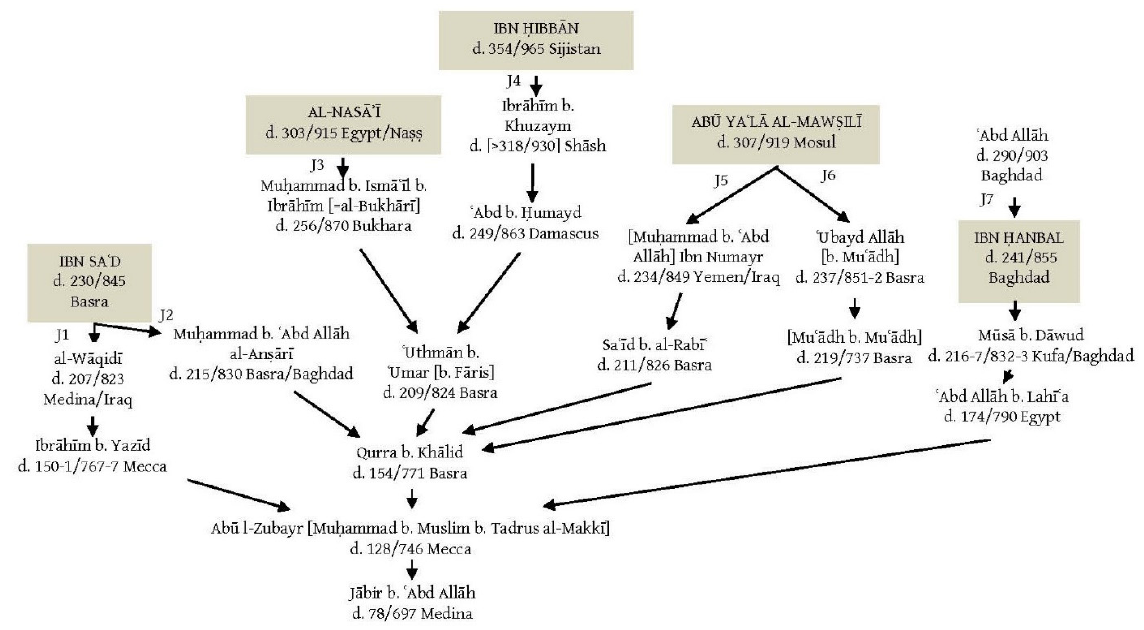
Figure 3. The isn ā d bundle of Ab ū l-Zubayr’s traditions from J ā bir b. ʿ Abd All ā